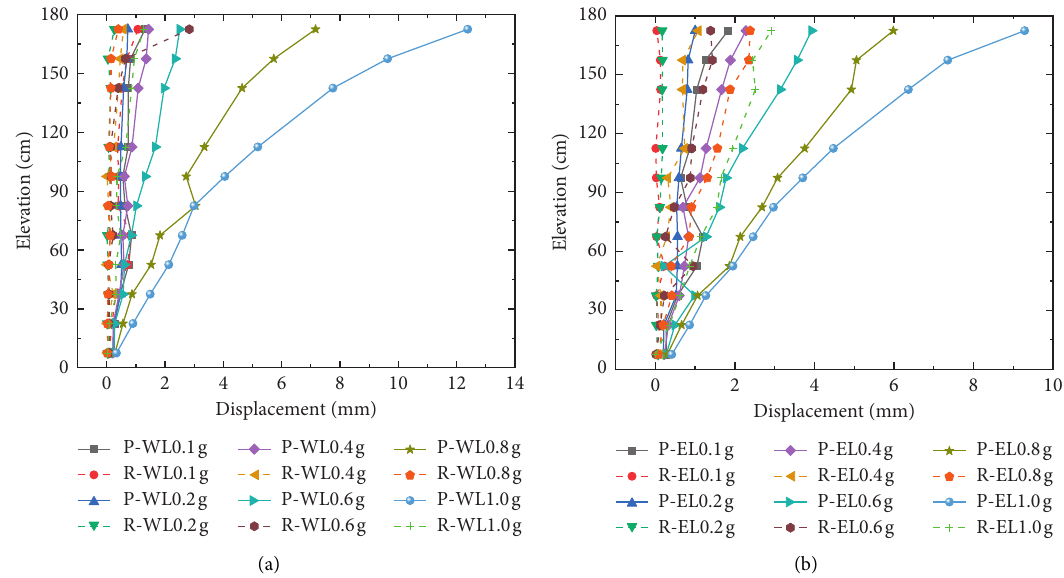
Figure 11: Lateral displacement distributions of the specimen (scale factor: 1/2): (a) WL and (b)